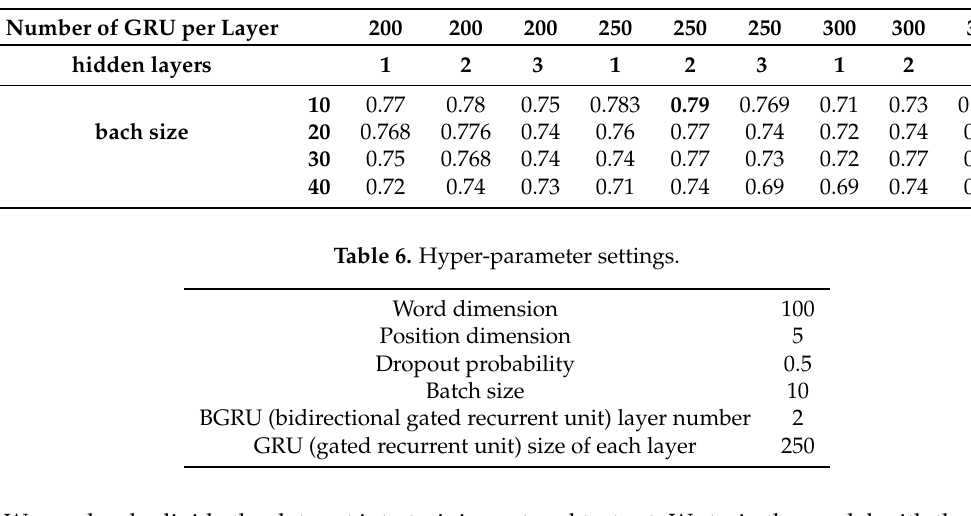
Figure 15. Comparison of experimental results of different parameter combinations. Table 5. Average accuracy of different hyper-parameters.